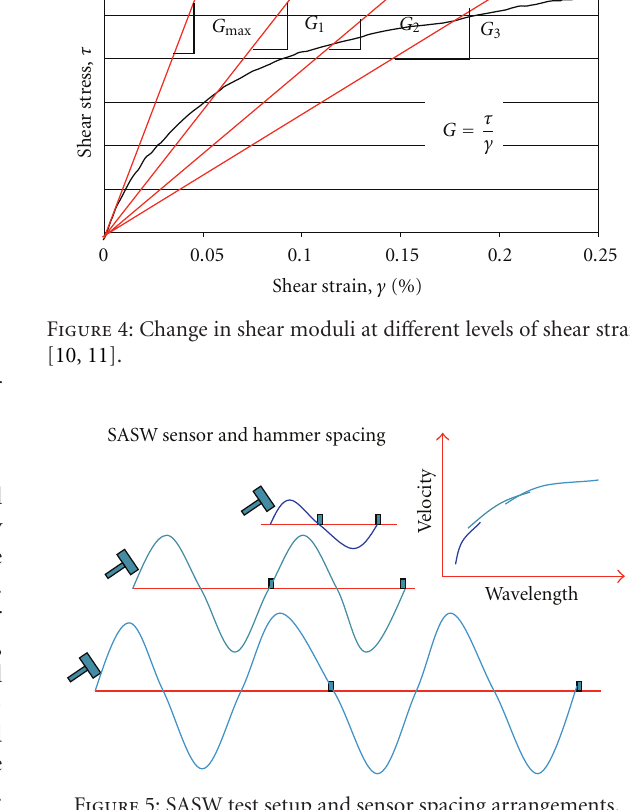
Figure 5: SASW test setup and sensor spacing